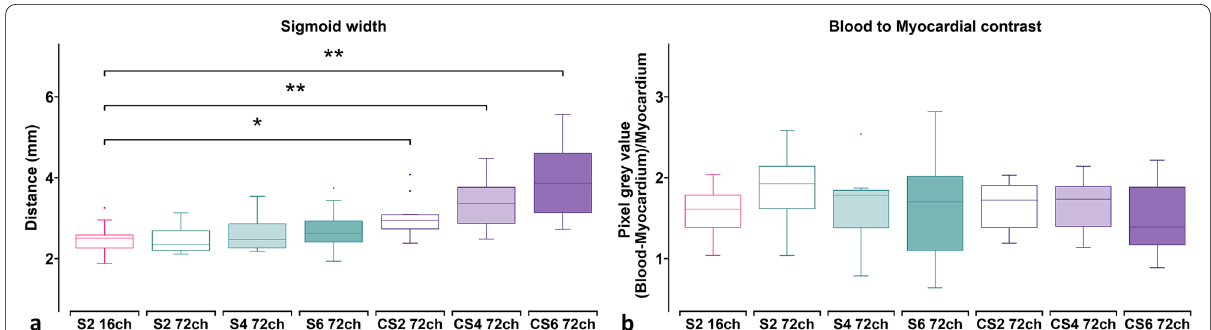
Fig. 3 Tukey box plots of ( a ) the width of the sigmoid curves and ( b ) blood-to-myocardium contrast normalised to the myocardium. The vendor-supplied 16-channel receiver array with SENSE-2 was considered the reference group for pairwise comparisons and depicted in red. Scans acquired with the new 72-channel receiver array are depicted in green for SENSE and purple for C-SENSE. ch Channel, CS Compressed sensitivity encoding, S Sensitivity encoding. * p < 0.05, ** p < 0.01